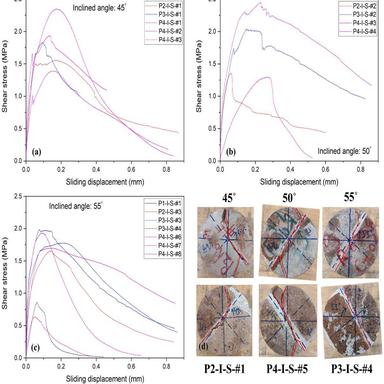
Stress-sliding relationship observed during shear tests on the I-shaped cores with the inclined angle: (a) 45˚; (b) 50˚; (c) 55˚; (d) failure modes for each inclined angle.